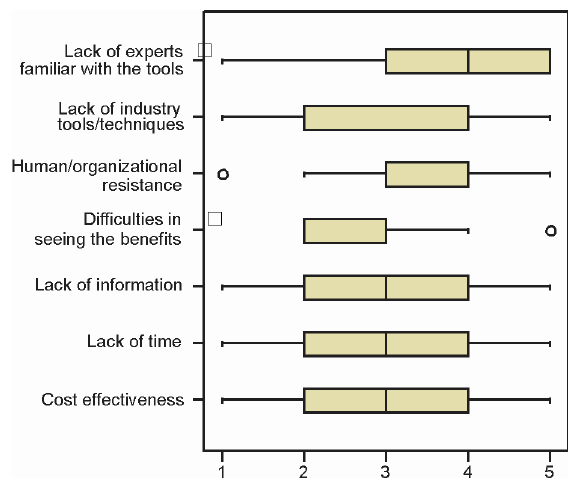
Fig. 10. Factors preventing risk management